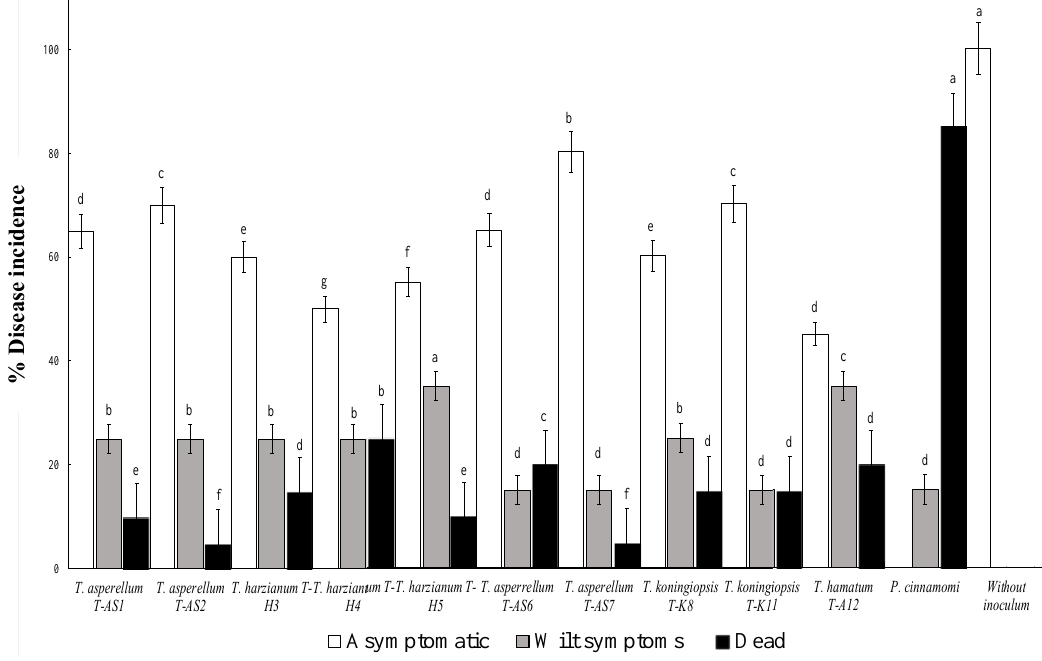
Figure 6. Avocado seedling interactions of 10 indigenous species of Trichoderma spp. inoculated individually with Phytophthora cinnamomi . The percentage of disease incidence is reduced under greenhouse conditions. Different letters denote the treatments that are significantly different according to Tukey’s test at p < 0.05.